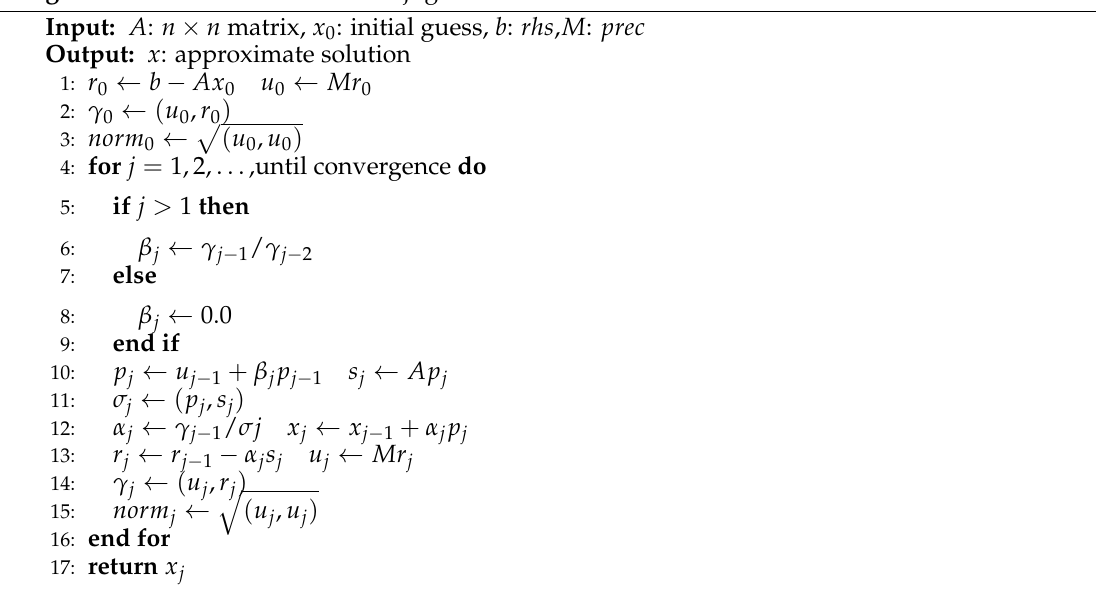
Algorithm 2: Preconditionded Conjugate